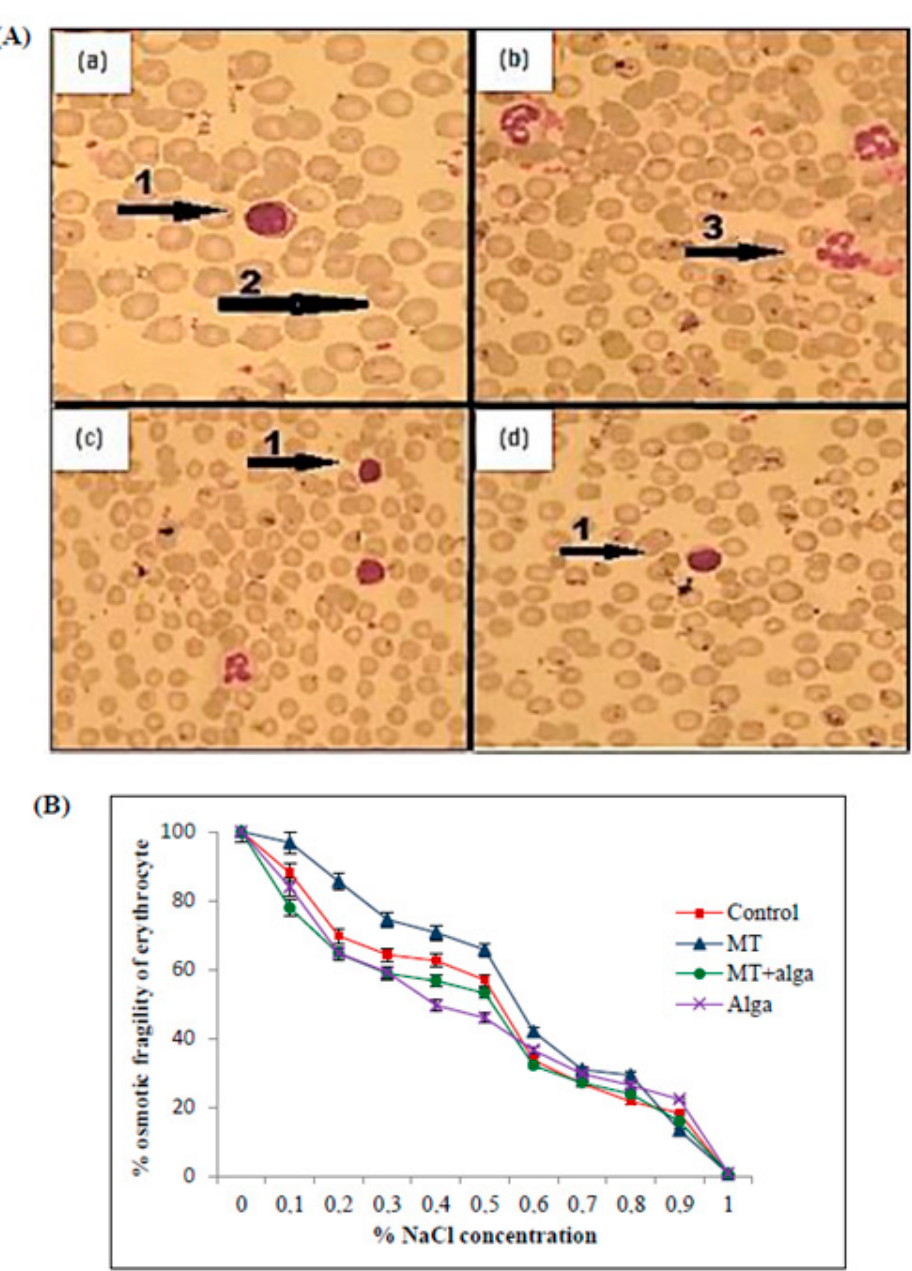
Figure 3. ( A ) Blood smear of adult rats ( × 100) in different experimental groups. ( a ) Control group; ( b ) rats treated with MT; ( c ) rats treated with MT + FRE; ( d ) rats treated with FRE. 1: Mononuclear leukocyte; 2: erythrocyte; 3: apoptotic cell. ( B ) Evolution of erythrocyte osmotic fragility in adult rats, controlled and treated for 7 days with MT, MT + FRE, and